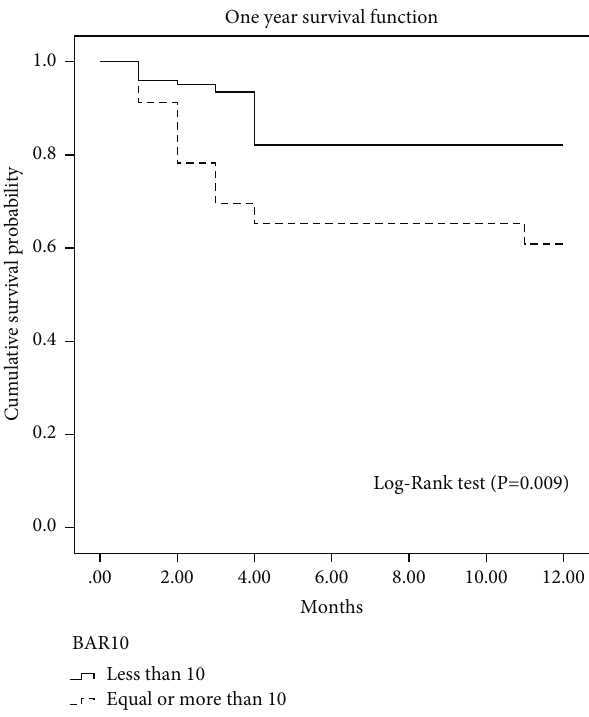
5: Post-transplant cumulative 1-year survival (Kaplan–Meier curve with log-rank test) for patients with the BAR score < and ≥ 10 points. BAR, balance of